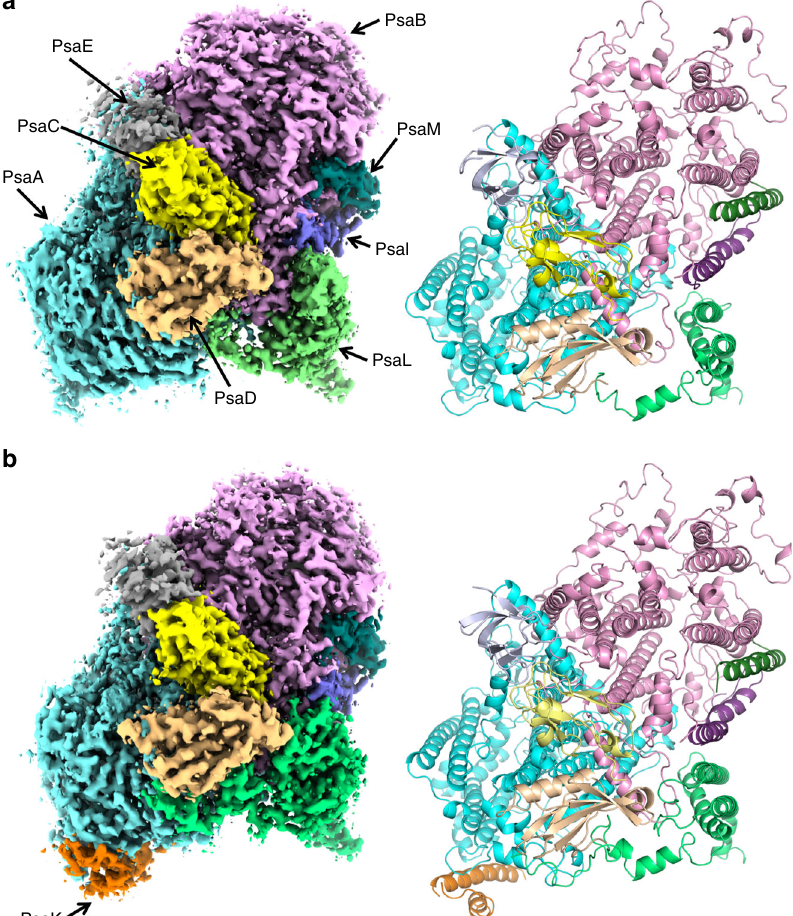
Fig. 1 Structure of white PSI and far-red PSI monomers. a Cryo-EM density map (left) and structure (right) of the white PSI monomer viewed along the membrane normal from the stromal side. b Cryo-EM density map (Left) and structure (Right) of the far-red PSI monomer viewed along the membrane normal from the stromal